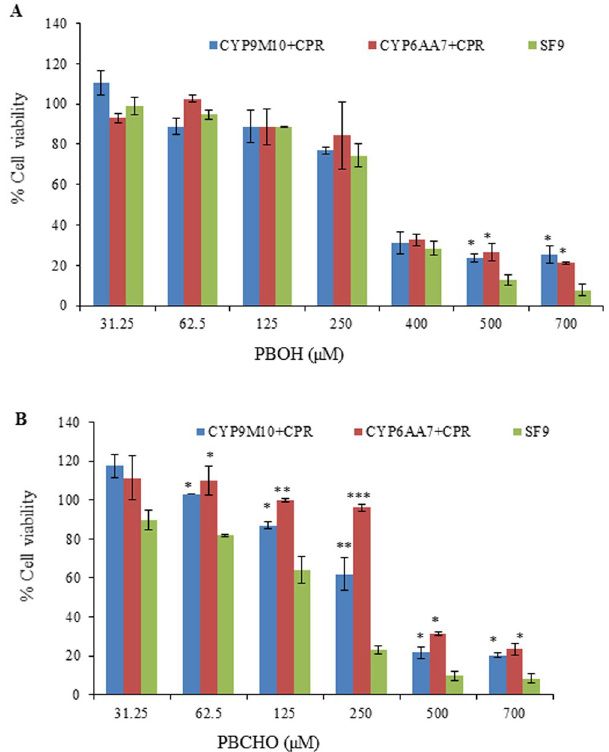
Figure 3. The role of CYP9M10/CPR and CYP6AA7/CPR in the detoxification of PBOH or PBCHO in Sf9 insect cells. ( A ) Viability of CYP9M10 or CYP6AA7 and CPR co-expressing Sf9 cells and Sf9 cells alone, treated with 31.25, 62.5, 125, 250, 400, 500, and 700 µ M of PBOH; ( B ) Viability of CYP9M10 or CYP6AA7 and CPR co-expressing Sf9 cells and Sf9 cells alone, treated with 31.25, 62.5, 125, 250, 400, 500, and 700 µ M of PBCHO. Student’s t-test was used for the statistical significance analysis. * P < 0.05; ** P < 0.01; *** P <